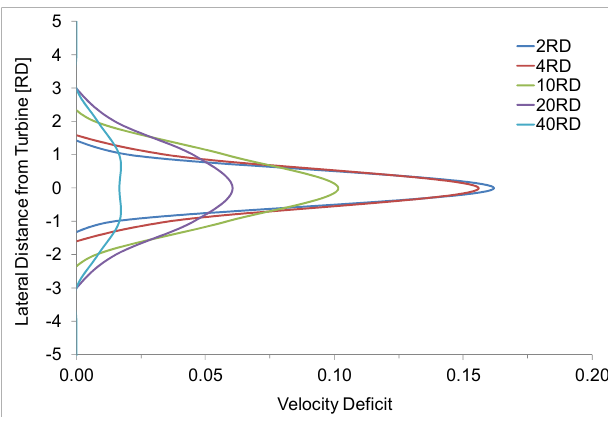
Figure 7. Velocity deficits along a number of lateral transects through the modelled turbine wake.